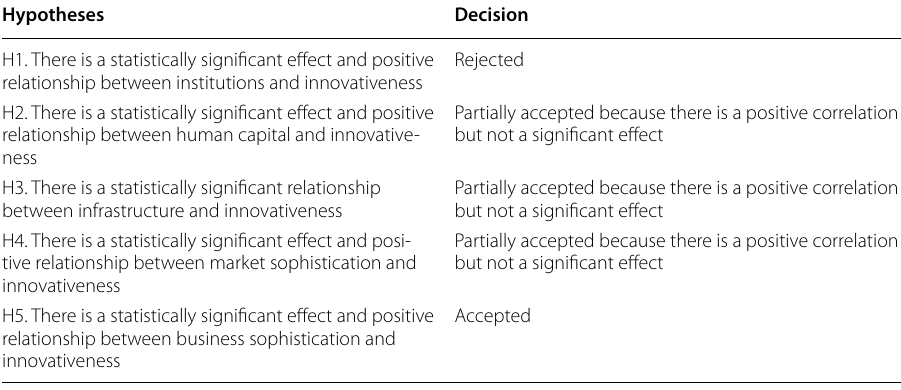
Table 3 Hypotheses testing result